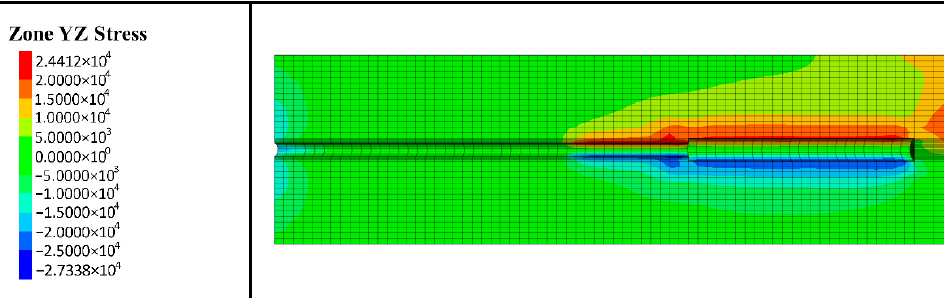
Figure 8. Distribution of shear stress at the grout–soil interface when the plastic zone of the anchor cable is connected.